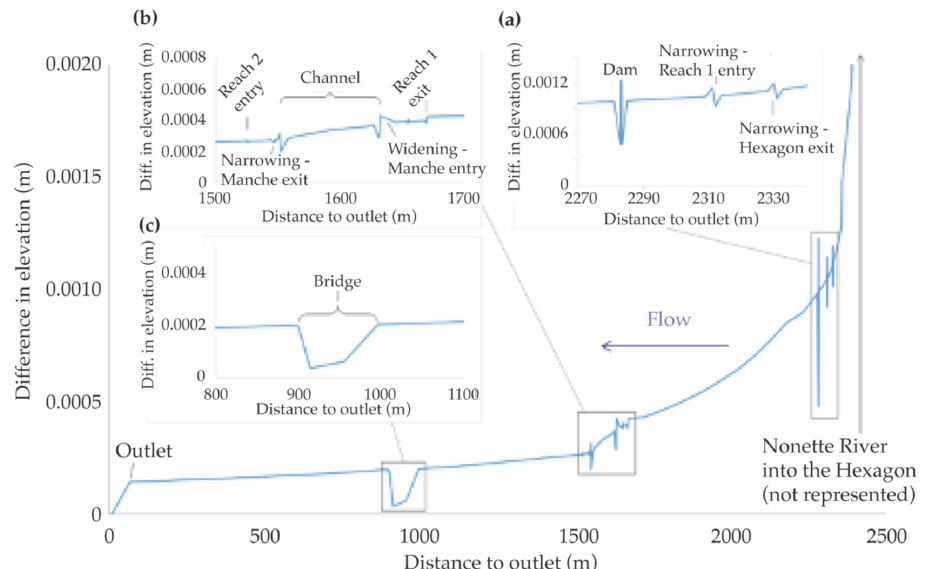
Figure 13. Calculated longitudinal profile of the deposition height downstream of the GC on 31 December 1987. ( a ) Details of the calculated longitudinal profile between the Hexagon exit and the dam. ( b ) Details of the calculated longitudinal profile in the vicinity of the Channel. ( c ) Details of the calculated longitudinal profile at the